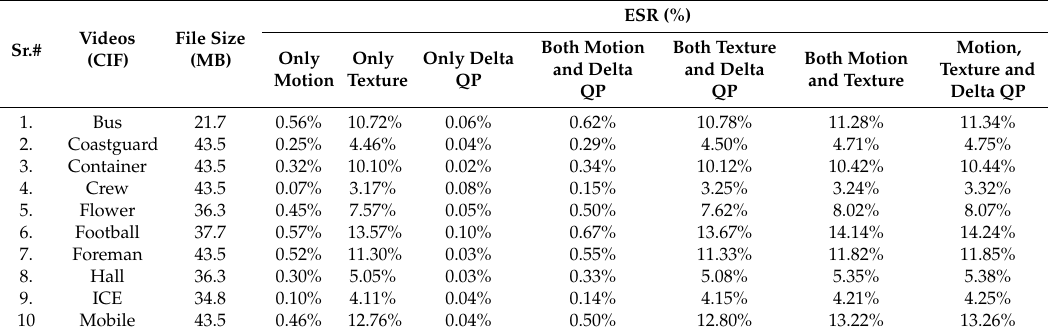
Table 4. ESR in terms of percentage over which selective encryption (SE) applied on CABAC bin-strings at QP =